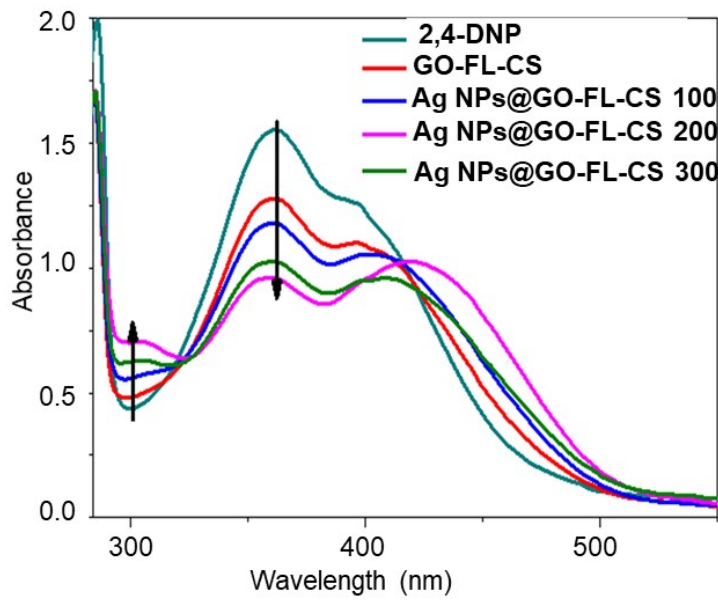
Figure 6. UV-Vis spectra for the reduction 2,4-DNP in 30 min treatment time.